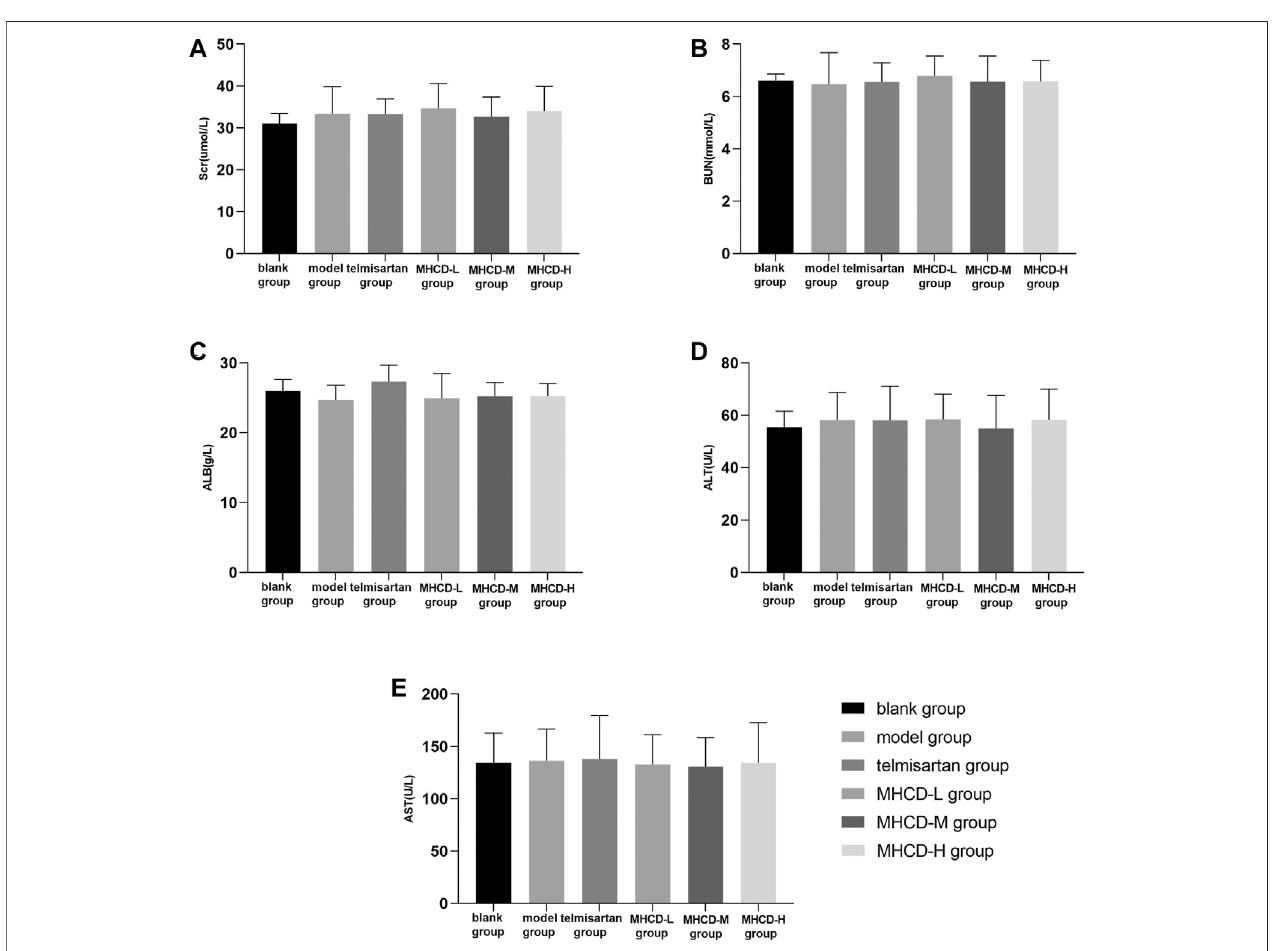
FIGURE4| MHCDdoesnotaltercertainbiochemicalmeasurementsofliverandkidneyfunctionwhileamelioratingproteinuria.Dataareexpressedasmeans ± SD ( n (cid:1) 10). Scr, serum creatinine; BUN, blood urea nitrogen; ALB, albumin; ALT, alanine transaminase; AST, aspartate transaminase.